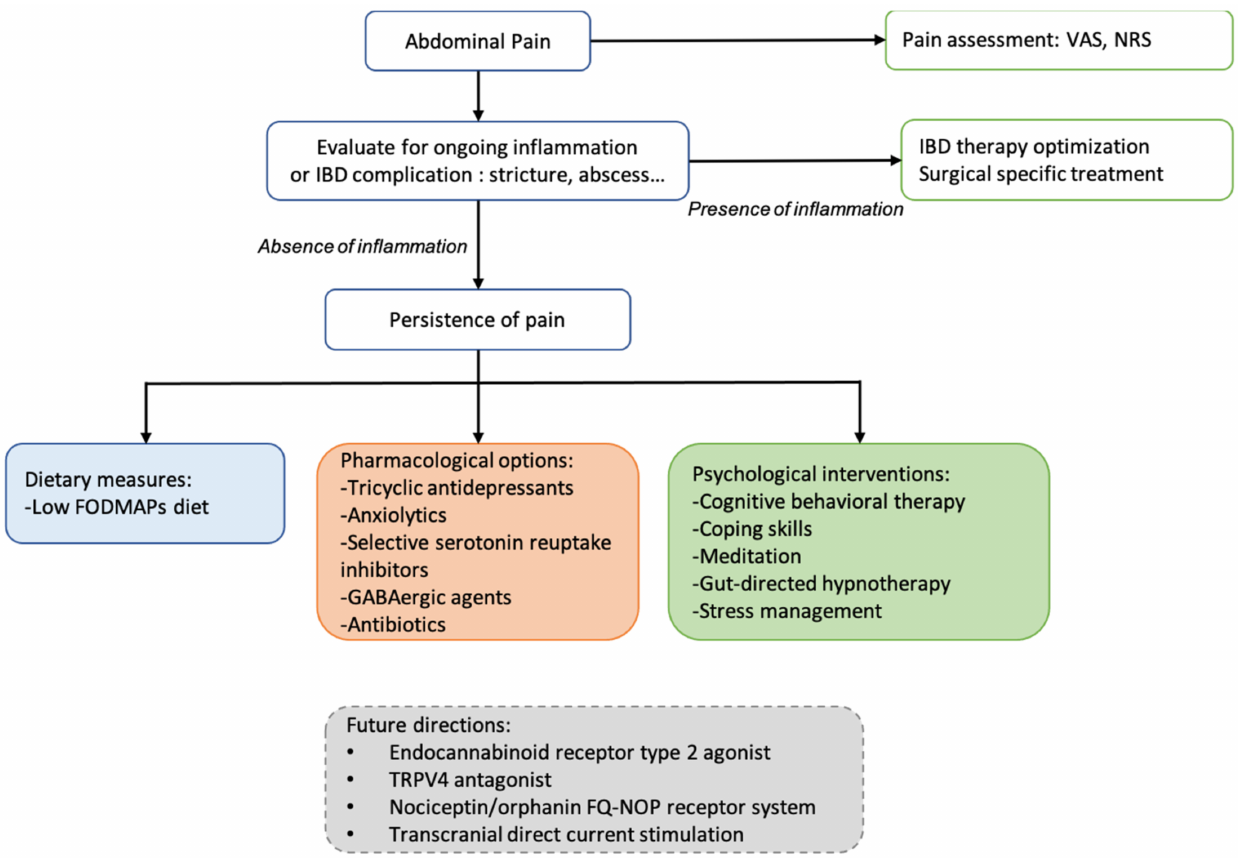
Figure 2. Proposed algorithm for pain management with pharmacological agents and non- pharmacological interventions available for improve chronic abdominal